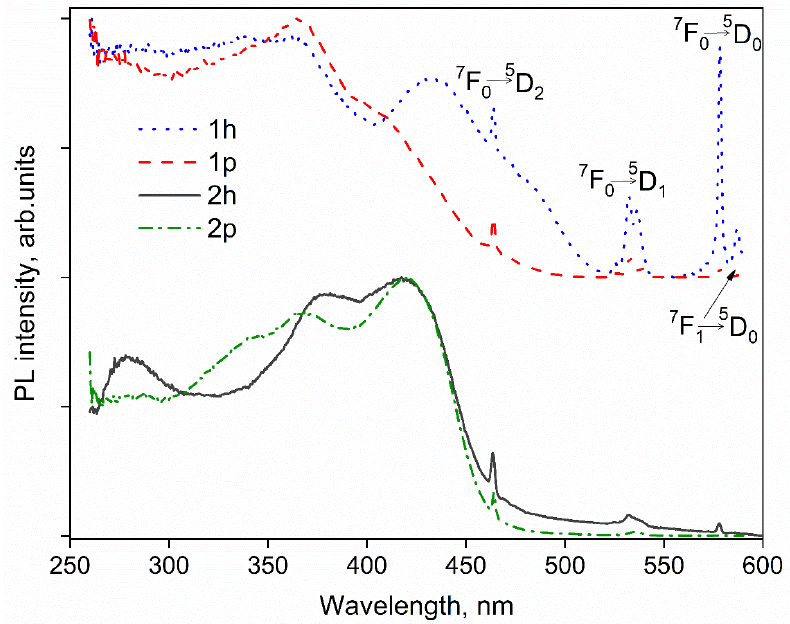
Figure 5. Optical excitation spectra of crystal complexes 1h – 2p recorded at room temperature; emission registration wavelength is 611 nm.